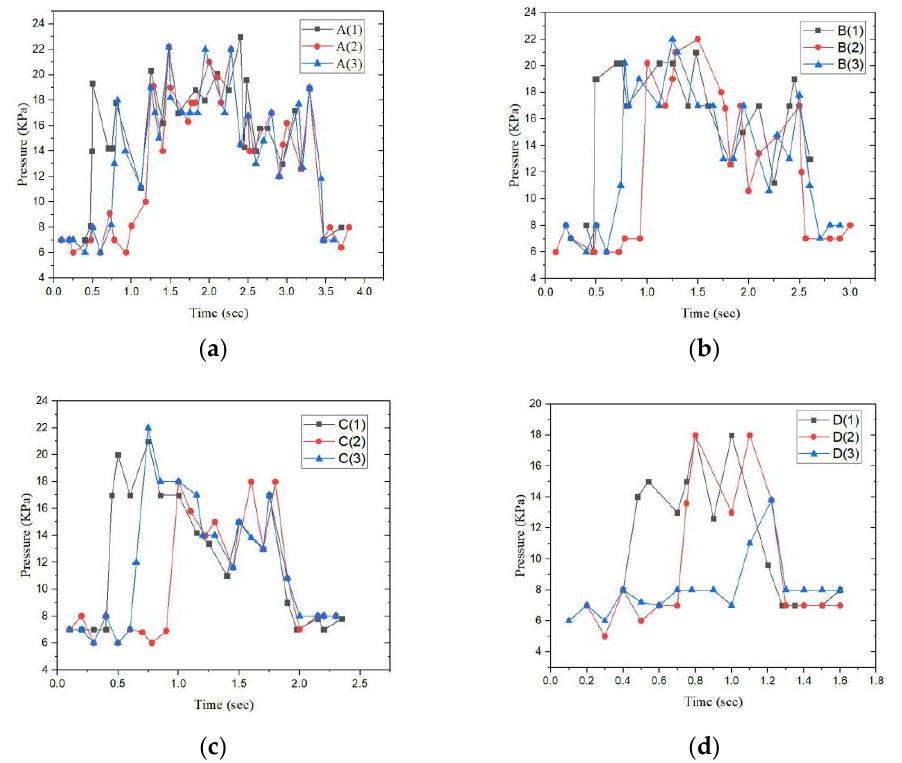
Figure 25. Pressure images of the different robot lengths at the A, B, C and D observation points: ( a ) Point A pressure curve; ( b ) Point B pressure curve; ( c ) Point C pressure curve; ( d ) Point D pressure curve.